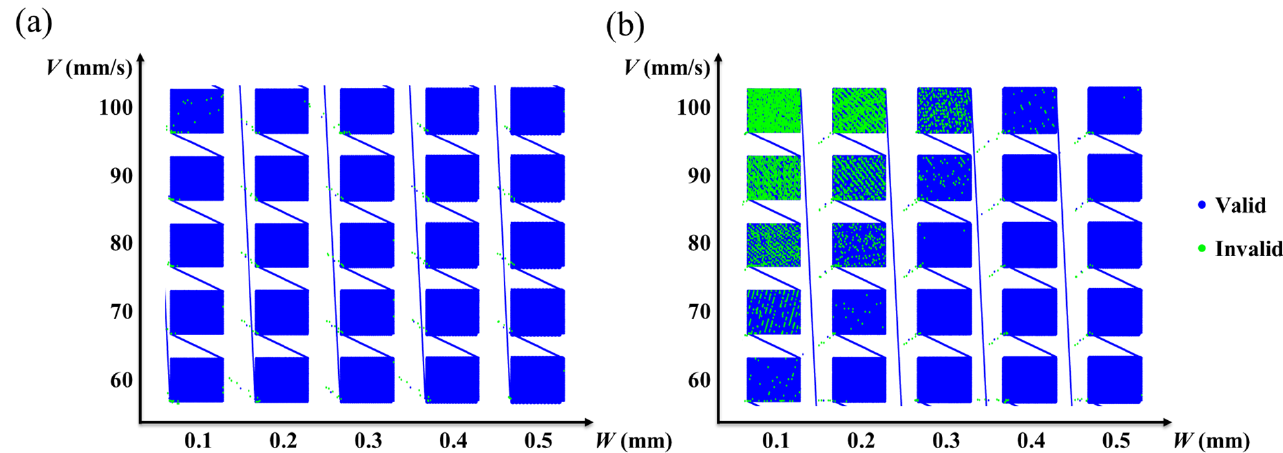
Figure 4. Reliable parameter judgment results ( a ) OL: 50% ( b ) OL: 66%.